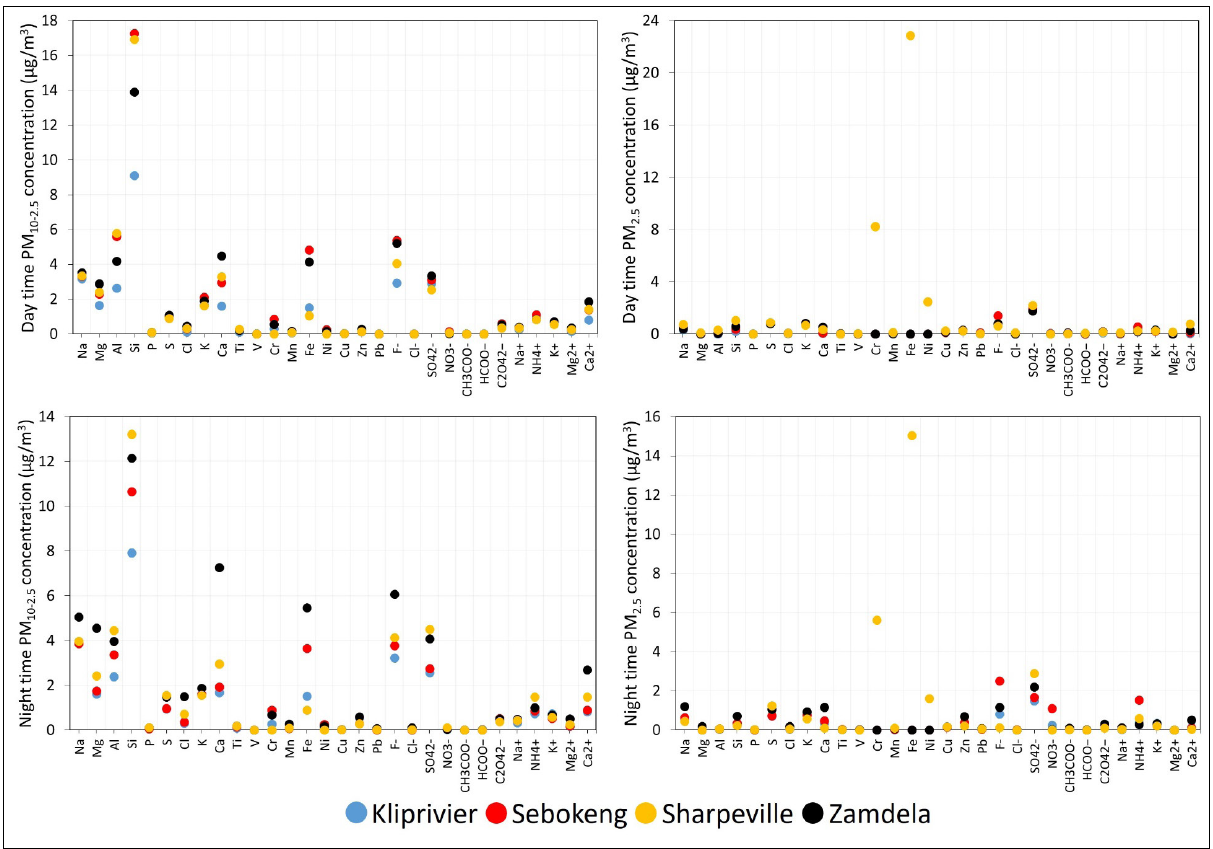
and PM at all the 10-2.5 2.5